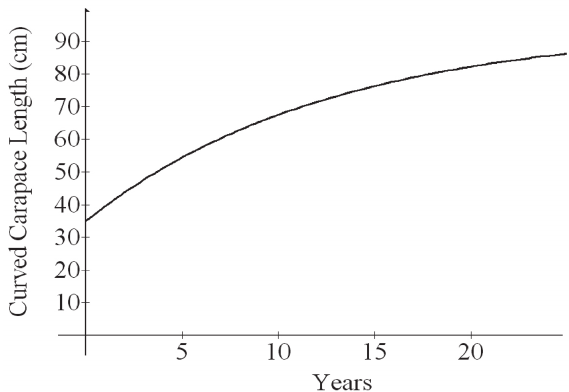
Fig . 3. – age-specific growth function for the Mediterranean log- gerheads generated by the von bertalanffy